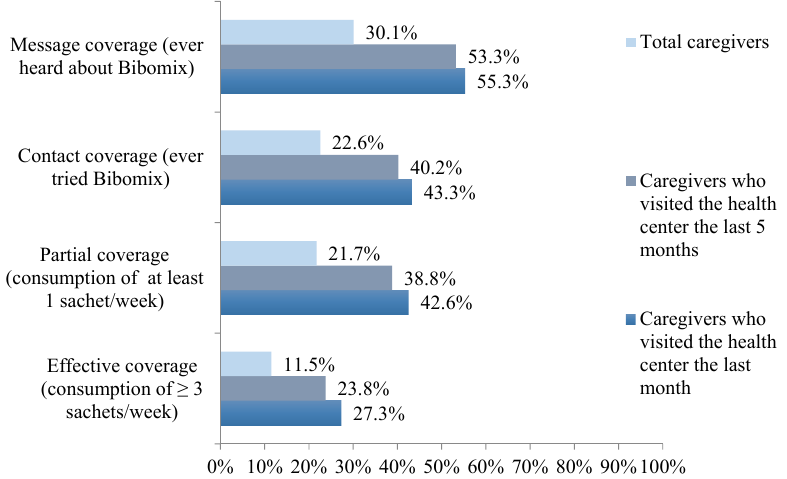
Figure 3. Coverage of the pilot in the four provinces by visit to the health centers.